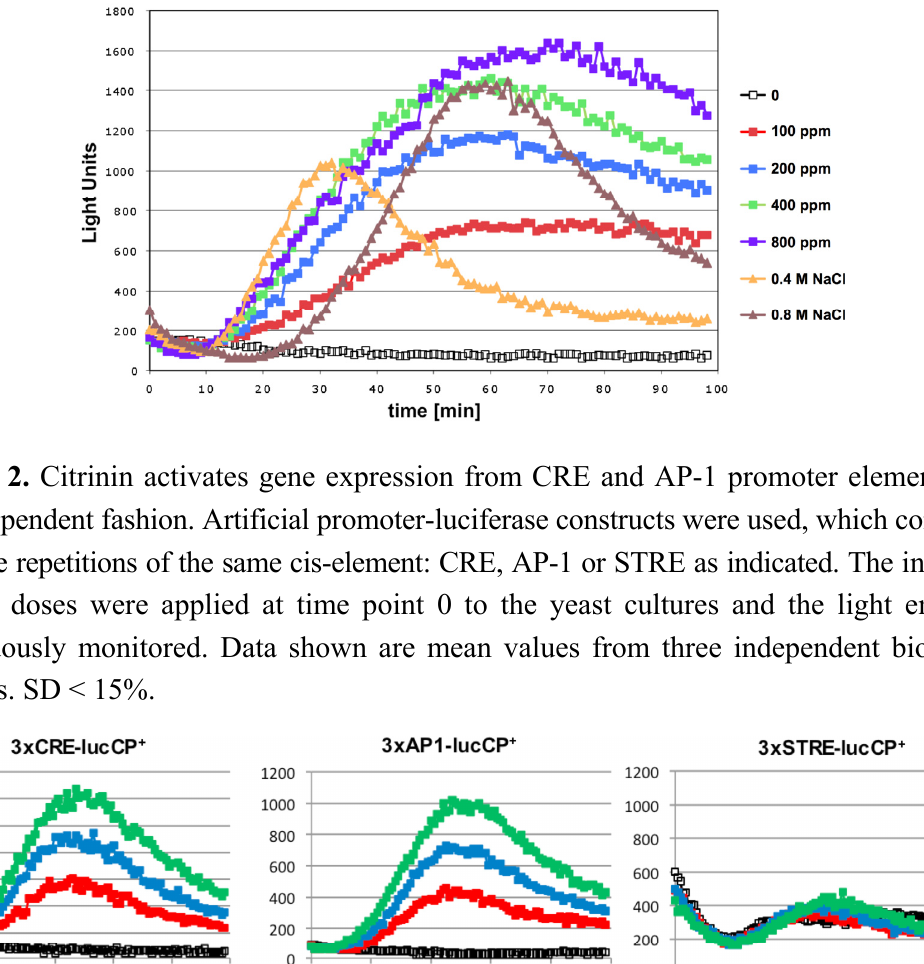
Figure 1. Citrinin activates gene expression from stress responsive yeast promoters in a dose dependent fashion. A fusion of the stress inducible GRE2 promoter with destabilized